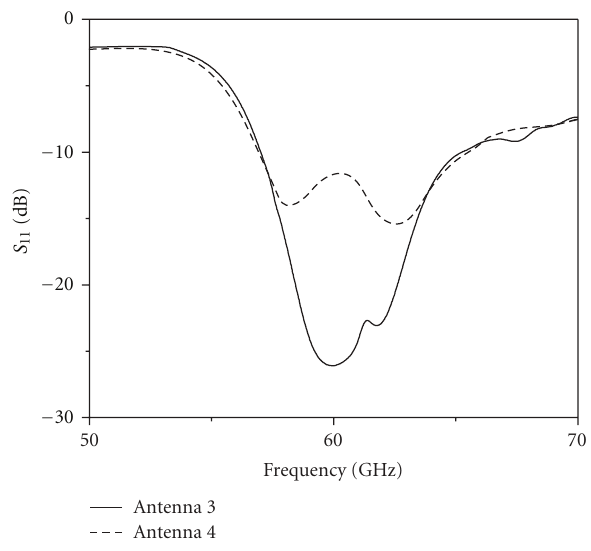
Figure 6: Reflection coe ffi cient magnitude for antenna 3 and antenna 4.